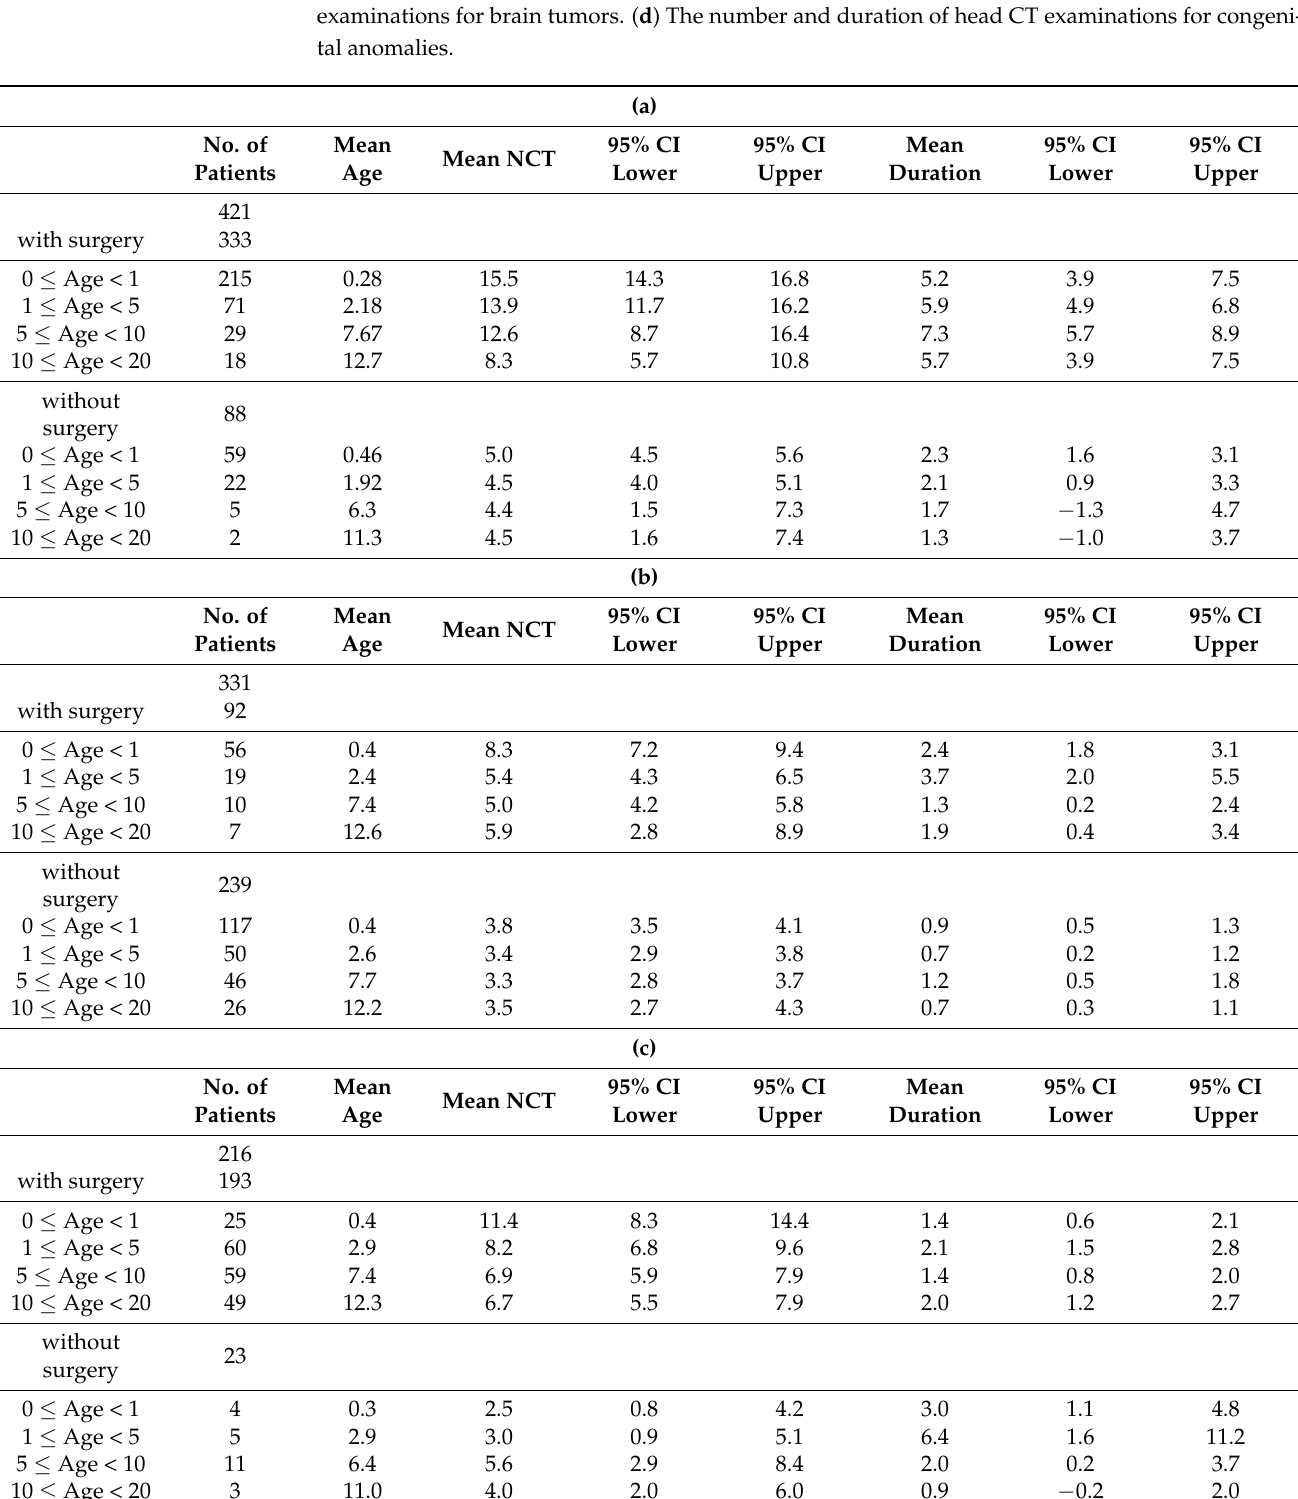
Table 2. ( a ) The number and duration of head CT examinations for hydrocephalus. ( b ) The num- ber and duration of head CT examinations for trauma. ( c ) The number and duration of head CT examinations for brain tumors. ( d ) The number and duration of head CT examinations for congeni- tal anomalies.